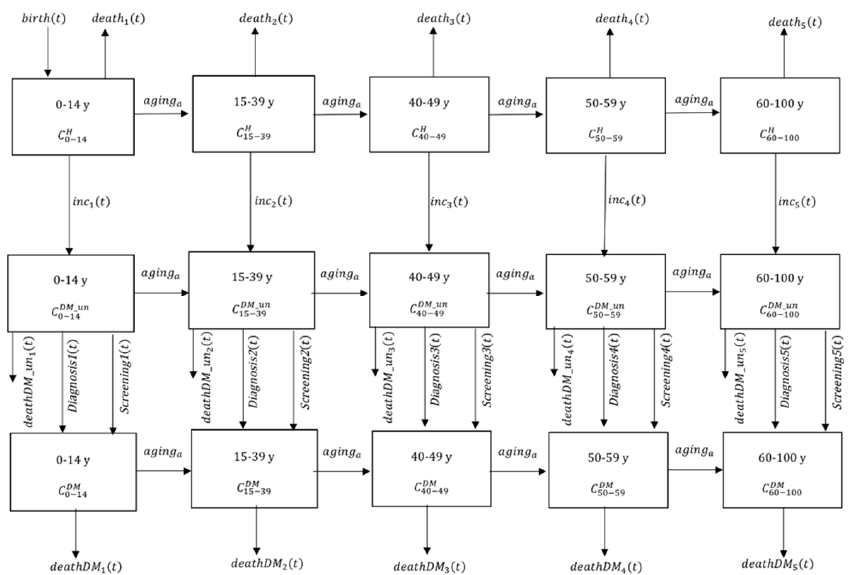
Figure 1. Schematic representation of the diabetes dynamic sub-model. C H a , C DM _ un a , and C DM a denote nondiabetic, undiagnosed, and diagnosed diabetes individuals, respectively.